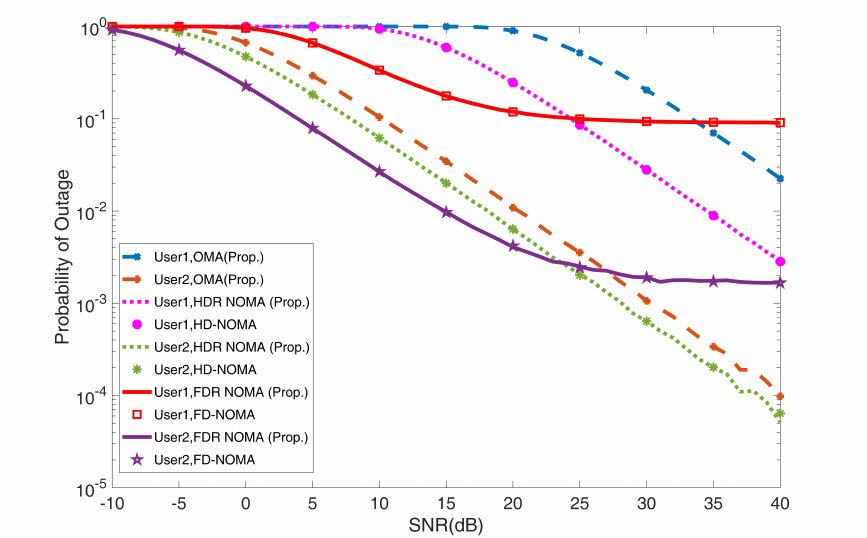
Figure 2. Outage probability versus the SNR for U 1 and U 2 under UAV − HDR/FDR − based NOMA and OMA schemes with B = 2 ( Rayleigh fading based HD/FD − NOMA [56]).